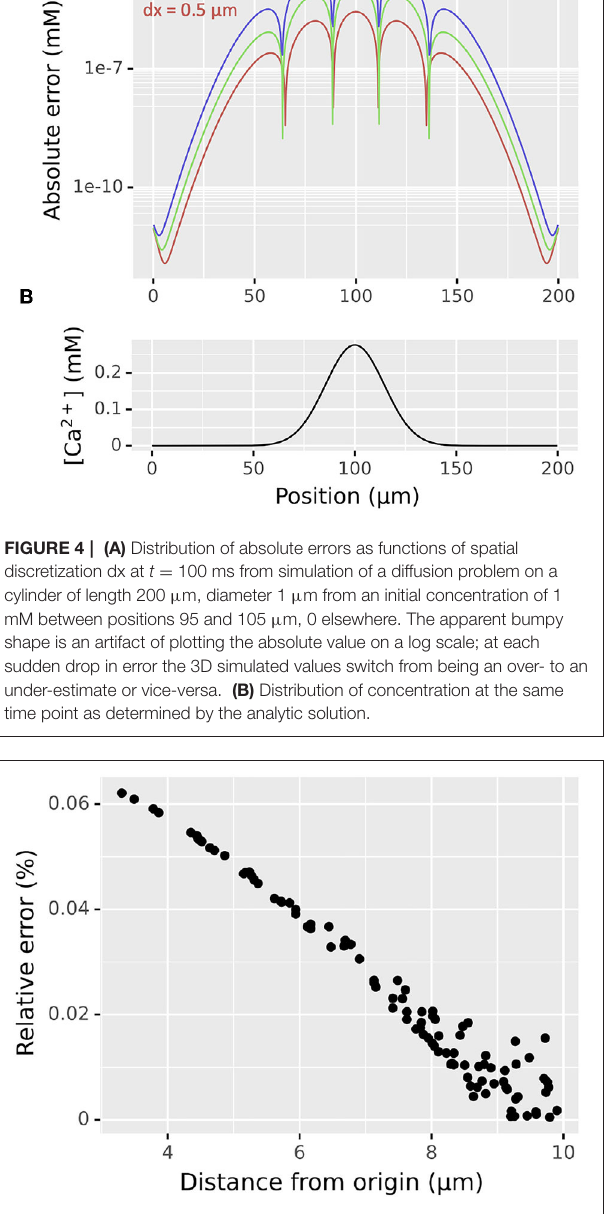
FIGURE 5 | Relative error vs. distance from the origin in 3D diffusion simulation from a cube of elevated concentration centered at the origin, simulated using the default spatial discretization; see text for